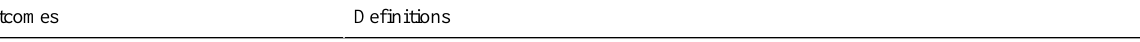
Table 1. Description of outcomes supporting the study’s primary objective to describe how implementation strategies affect the implementation